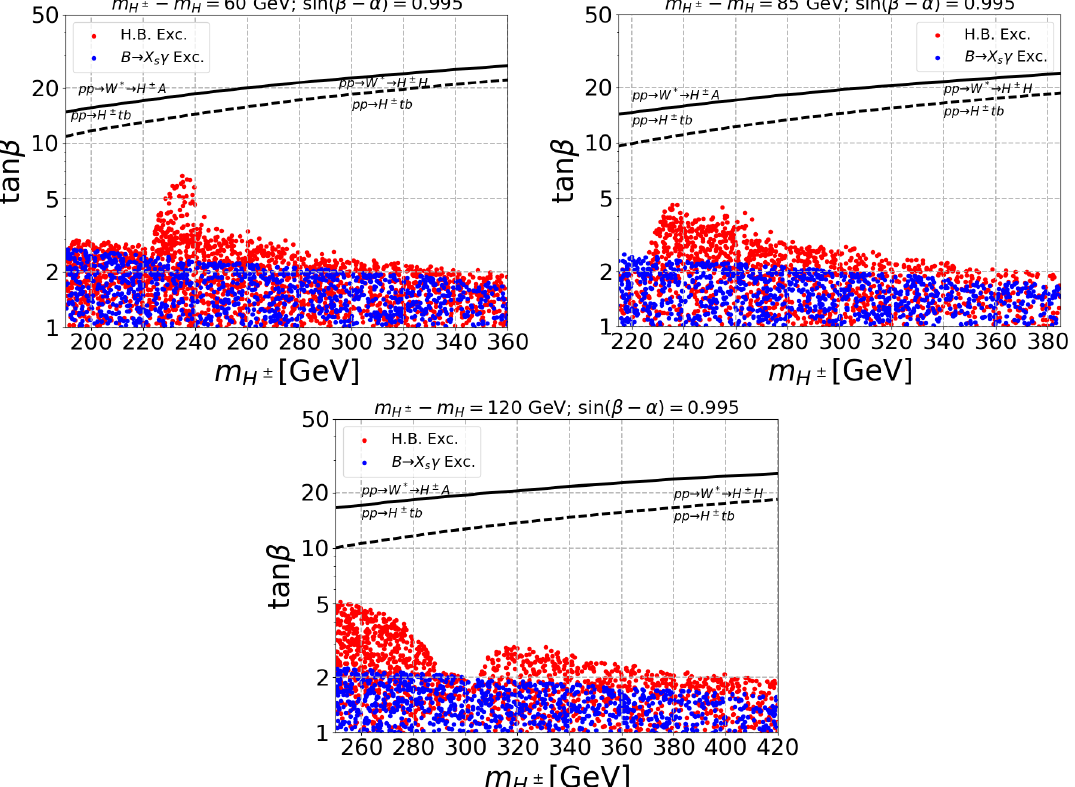
Figure 1 . Experimental constraints on m − tan β plane is shown. The exclusion limits coming H ± from LHC are shown in red points, and the blue points show the excluded regions coming from the BR( B → X ) constraint. Above the dashed(solid) black line the electroweak charged Higgs s γ production pp → W ∗ → H ± H ( pp → W ∗ → H ± A ) dominates over the top associated channel ( pp → H ± tb